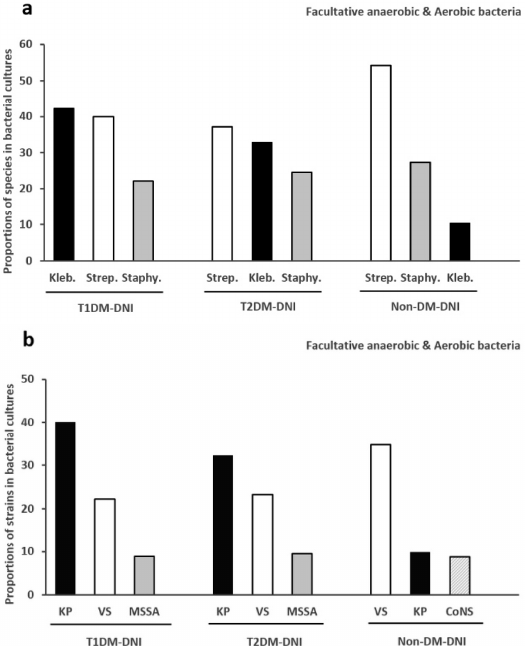
Figure 2. ( a ): Top three species of facultative anaerobes and aerobes in T1DM-DNI, T2DM-DNI, and non-DM-DNI. ( b ): Top three bacteria of facultative anaerobes and aerobes in T1DM-DNI, T2DM-DNI, and non-DM-DNI. Abbreviations: Kleb., Klebsiella species; Strep., Streptococcus species; Staphy., Staphylococcus species. KP, Klebsiella pneumoniae; VS, Viridians Streptococci; MSSA, methicillin-sensitive Staphylococcus aureus; CoNS, coagulase-negative Staphylococcus. DNI, deep neck infection; T1DM, type 1 diabetes mellitus; T2DM, type 2 diabetes mellitus.